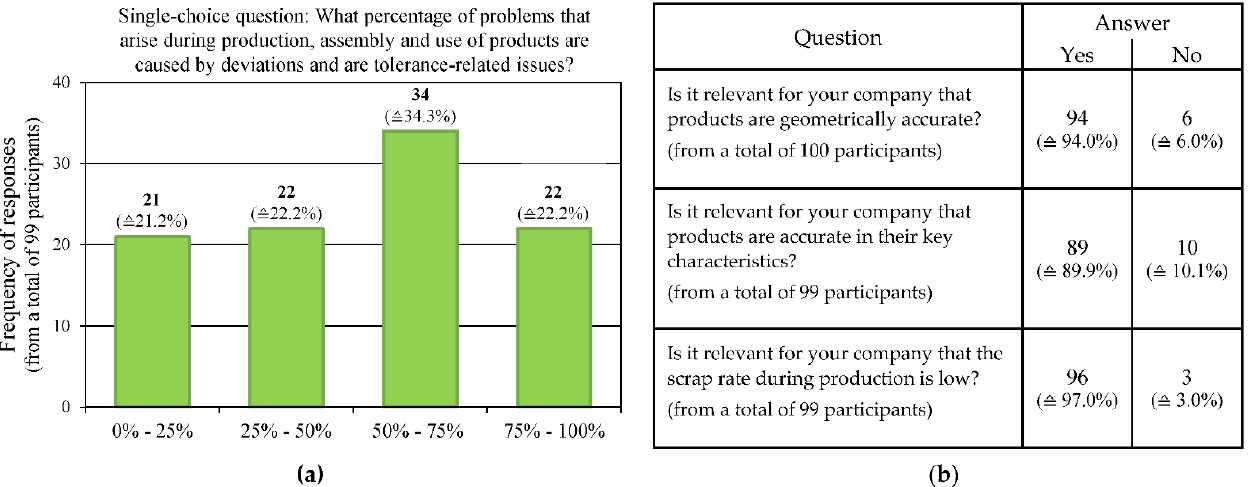
Figure 3. ( a ) Response of 99 participants to the (single–choice) question: “What percentage of problems that arise during production, assembly and use of products are caused by deviations and are tolerance-related issues?”; ( b ) response of participants to selected (single–choice) questions.